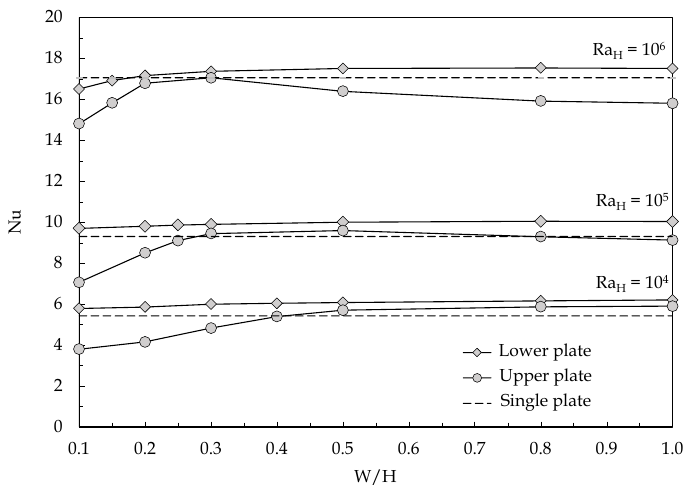
Figure 8. Nu vs. W / H for L / H = 0 (fully staggered plates) using Ra H as the parameter.